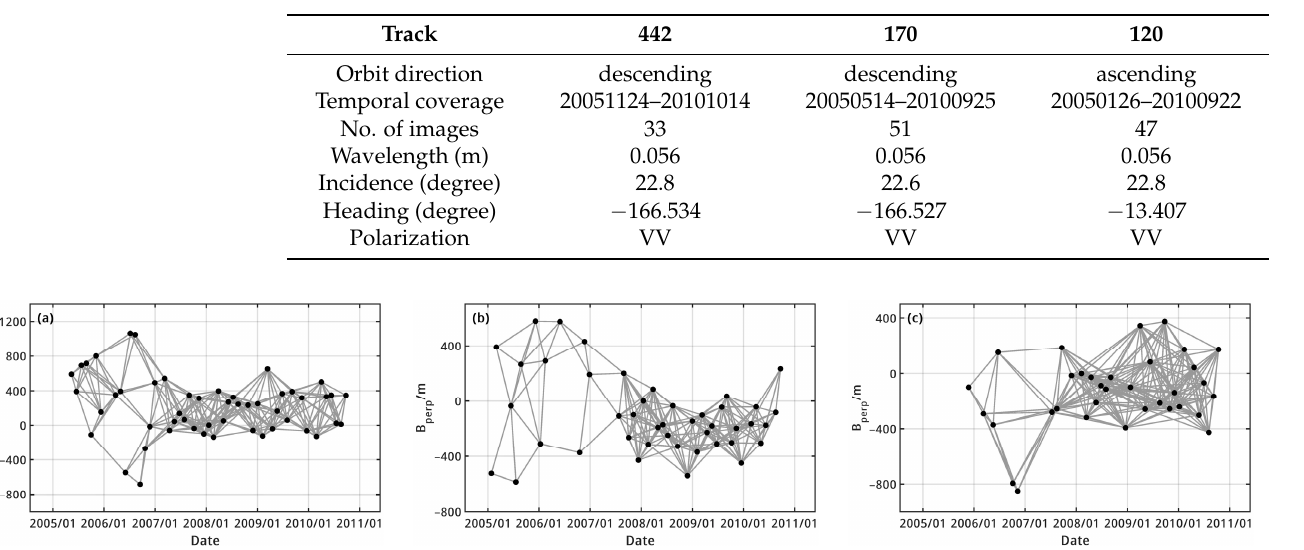
Table 1. List of parameters for the three ENVISAT ASAR SAR datasets.